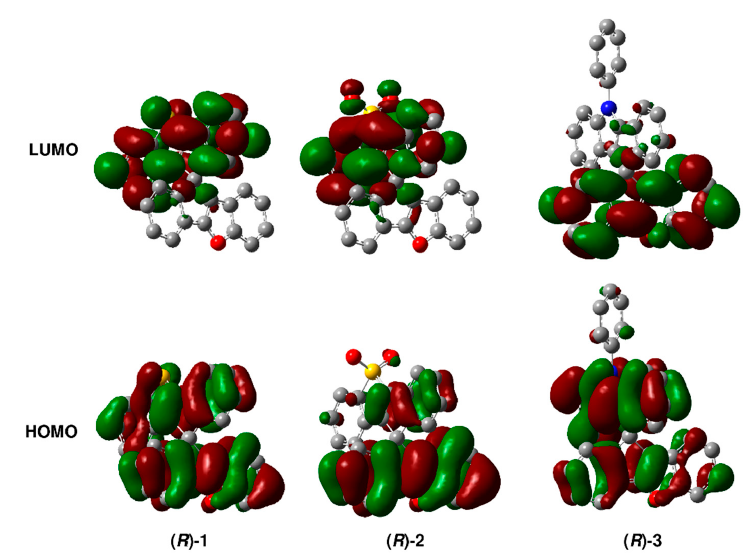
Figure 5. Frontier molecular orbitals of ( R )- 1 – 3 .